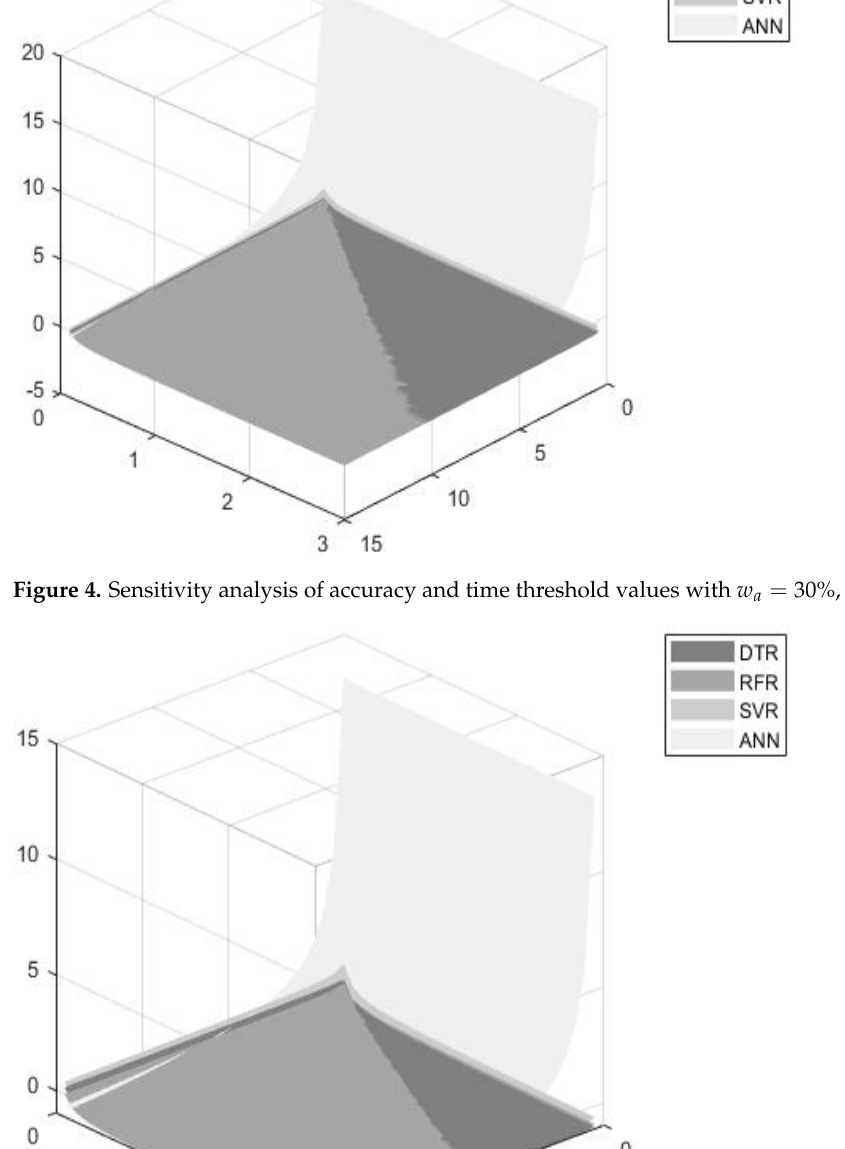
Figure 3. Sensitivity analysis of accuracy and time threshold values with 𝑤 (cid:3028) = 20% , 1- 𝑤 (cid:3028) = 80%